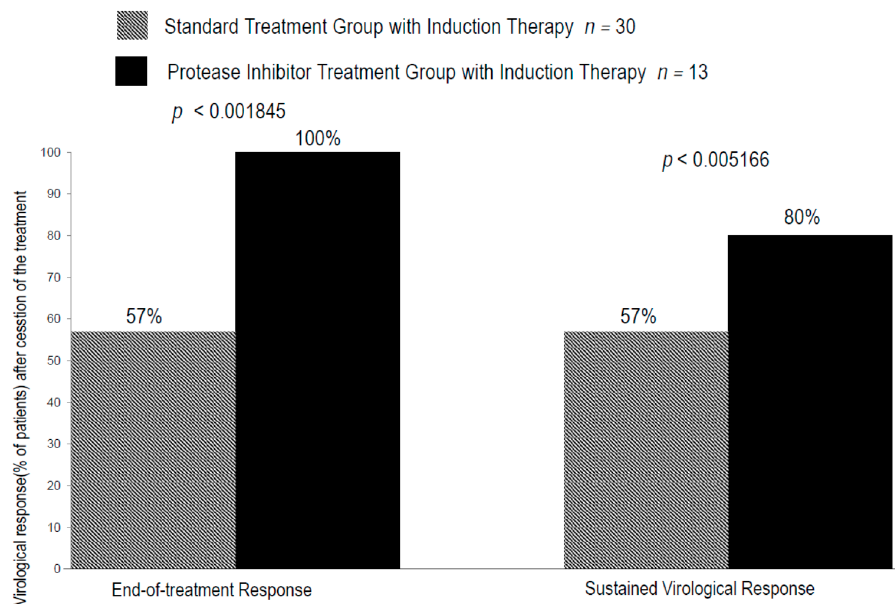
Figure 5. Rate of virologic responses at the end-of treatment and rate of sustained virologic response in chronic hepatitis C patients with genotype 1b and high viral loads in standard treatment with induction therapy with nIFN- β and protease inhibitor treatment with induction therapy with nIFN- β . Virologic response was defined as undetectable serum level HCV.RNA (<15 IU/mL). The paired- t test was used to evaluate the differences of the means between two groups with a p -value of <0.05 considered significant.